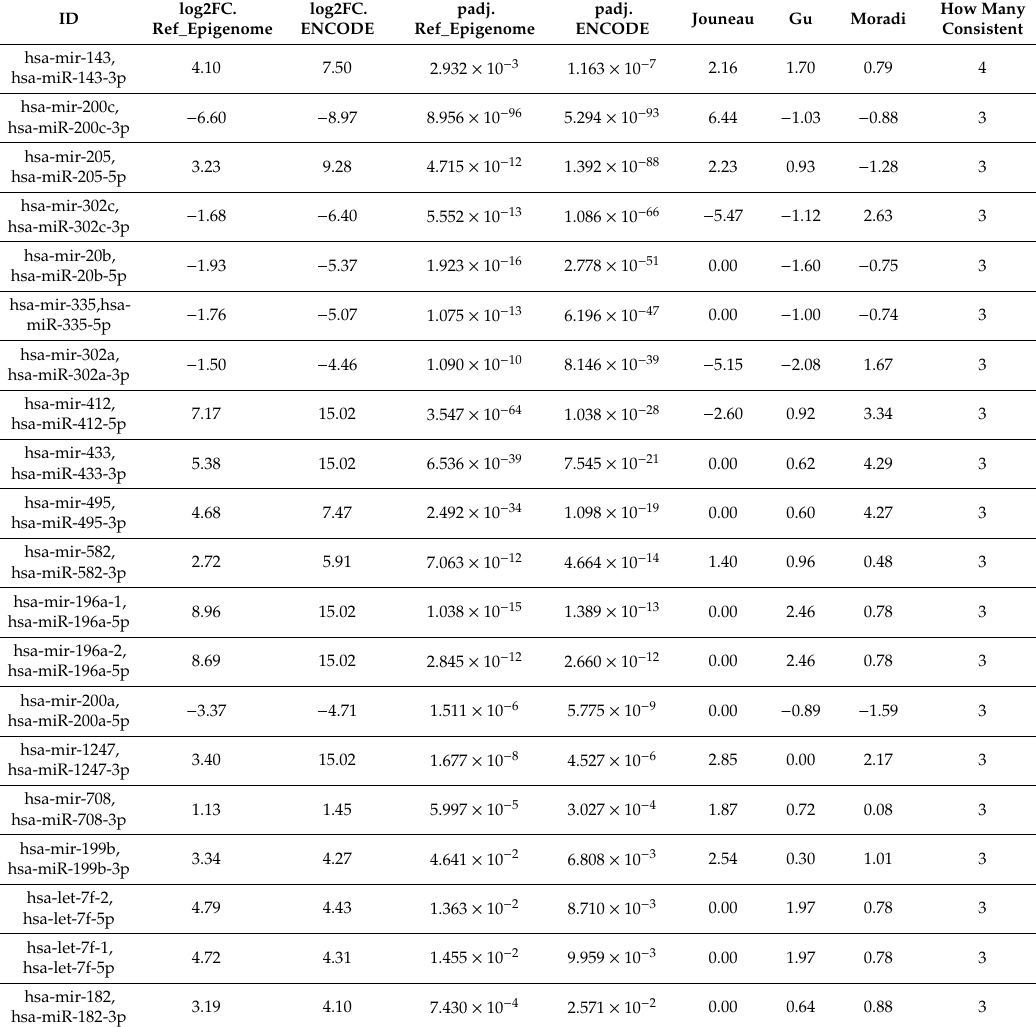
Table 4. microRNAs showing consistent changes in at least three out of four